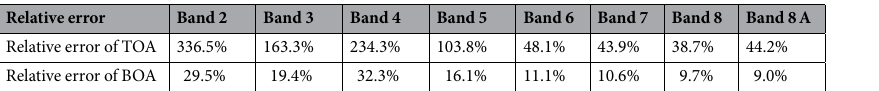
Table 3. Comparison of relative errors of Sentinel-2A reflectivity. Note: the relative errors of TOA and BOA were the relative errors of the measured reflectance with TOA and BOA,